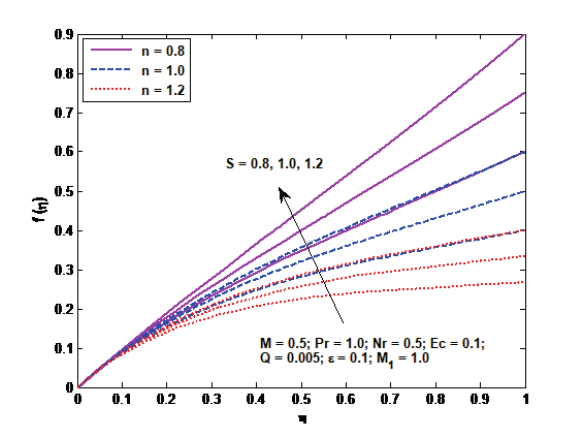
Fig. 10: Temperature profiles for different values of Pr